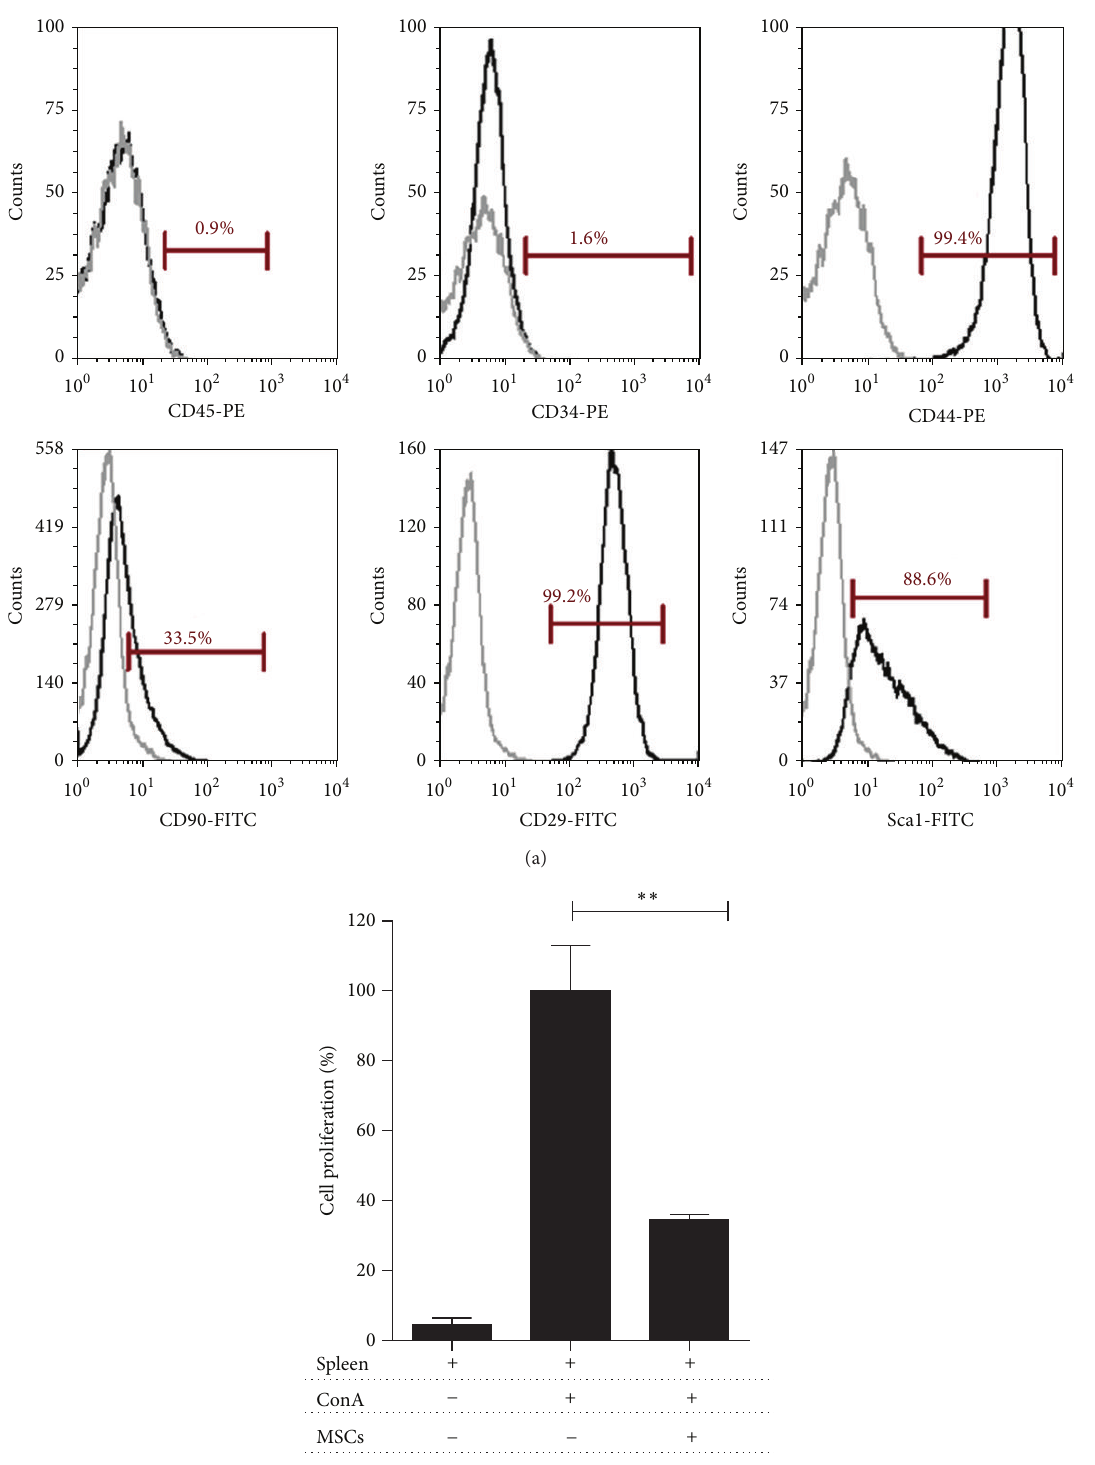
Figure 1: Murine MSCs characterization. (a) Phenotypic characterization of MSCs. Cells were stained for classical murine MSCs markers (CD45, CD34, CD44, CD90, CD29, and Sca-1) and evaluated by flow cytometry using a Beckman Coulter Epics XL and FCS Express V4 Plus Research Edition software. Representative histograms for each antigen are shown in black and overlapping isotype controls in grey. (b) Immunosuppressive capacity of MSCs. Splenocytes were CFSE-stained and stimulated with Concanavalin A (3 𝜇 g/mL) (ConA) in the presence or absence of MSCs for 5 days. Nonstimulated cells were used as negative controls. T cell proliferation was evaluated by flow cytometry, gating on CD4+ cells. Results are shown as the mean ± SEM. 𝑃 values were calculated using the unpaired Mann-Whitney test ( ∗∗ 𝑃 < 0.005 ), 𝑛 = 3